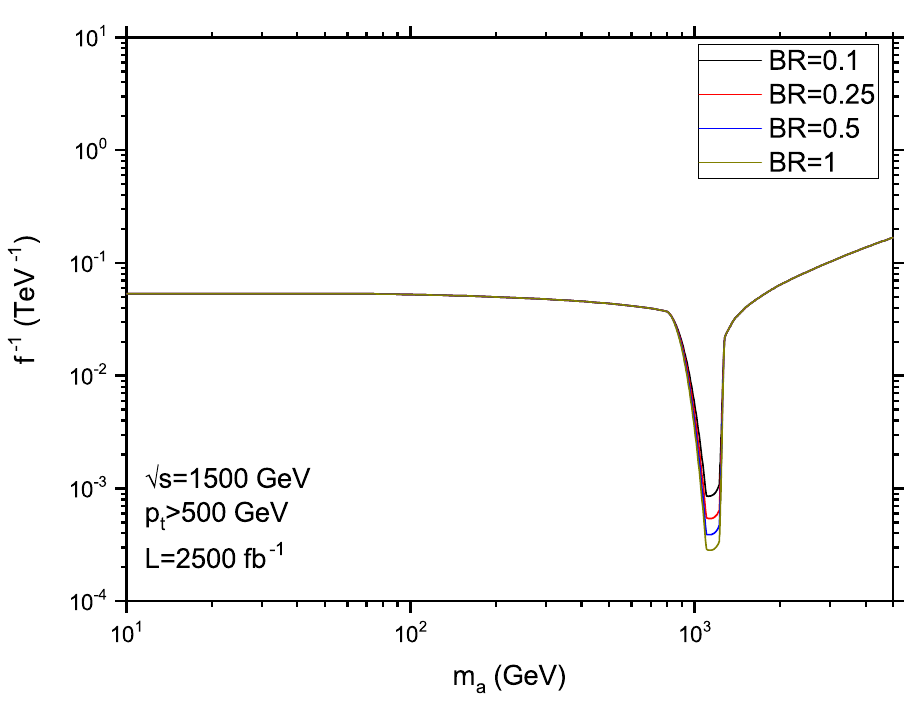
Figure 5 . The 95% C.L. CLIC exclusion region for the process γγ photons with the invariant energy √ s = 1500 GeV, cut W > 200 GeV on the photon invariant mass, integrated luminosity L = 2500 fb − 1 , and different values of Br( a